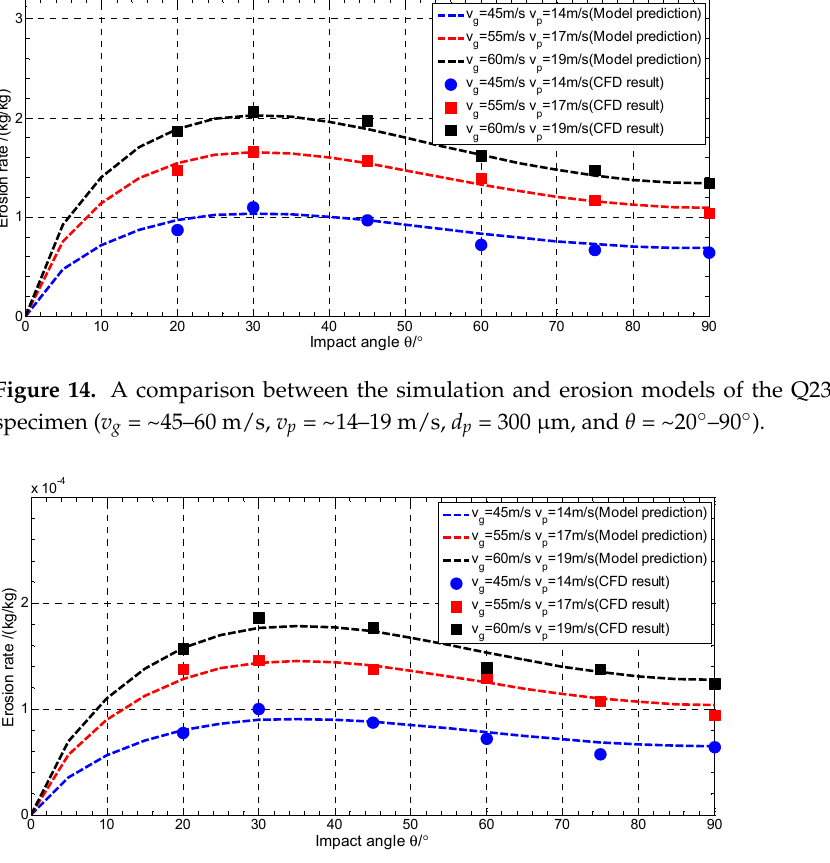
Figure 15. A comparison between the simulation and erosion models of the A304 stainless steel specimen ( v g = ~45–60 m/s, v p = ~14–19 m/s, d p = 300 µ m, and θ = ~20 ◦ –90 ◦ ).